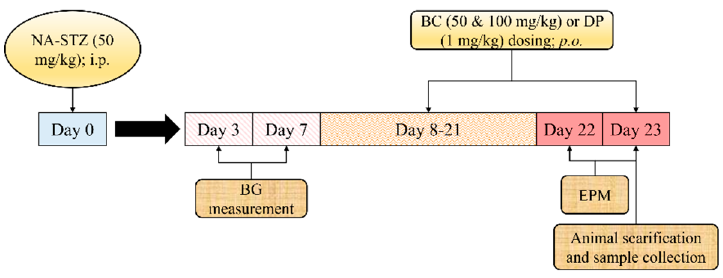
Figure 1. Experimental protocol of the study.